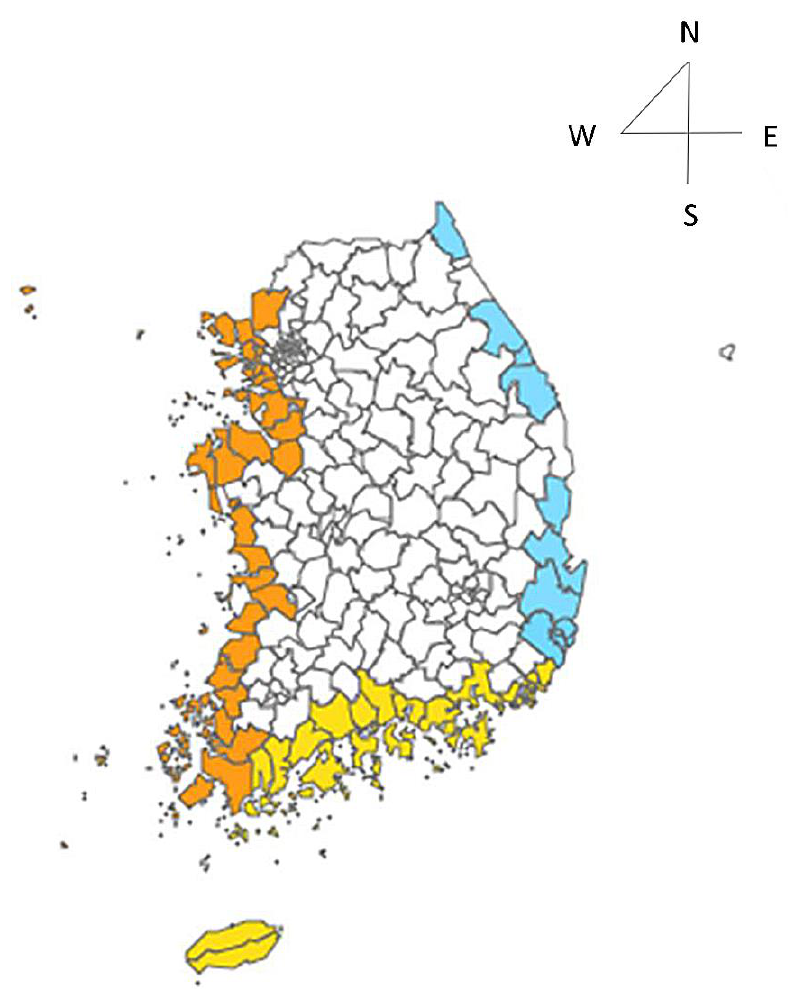
Figure 1. Coastal areas examined in the